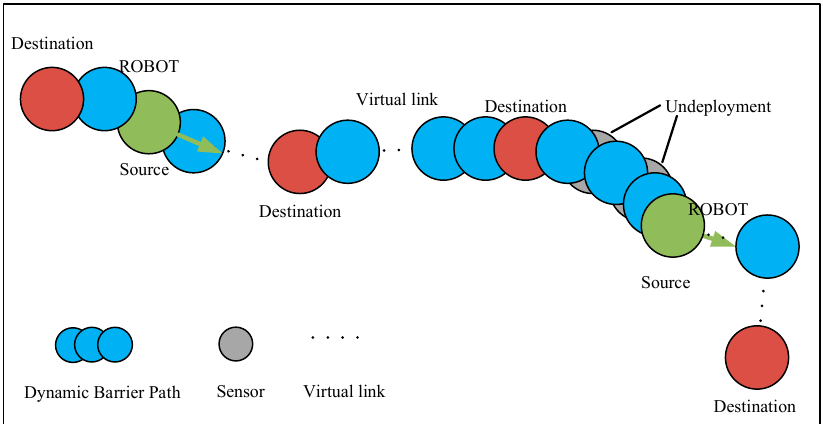
Figure 2. A typical coverage graph of Dynamic Barrier Coverage (DBC).